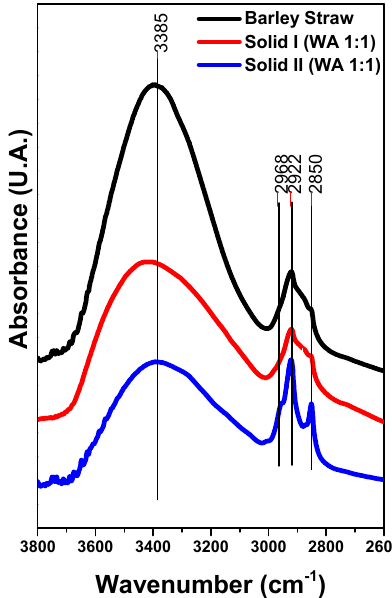
Figure 2. FTIR spectra of Solid I, Solid II and raw barley straw.